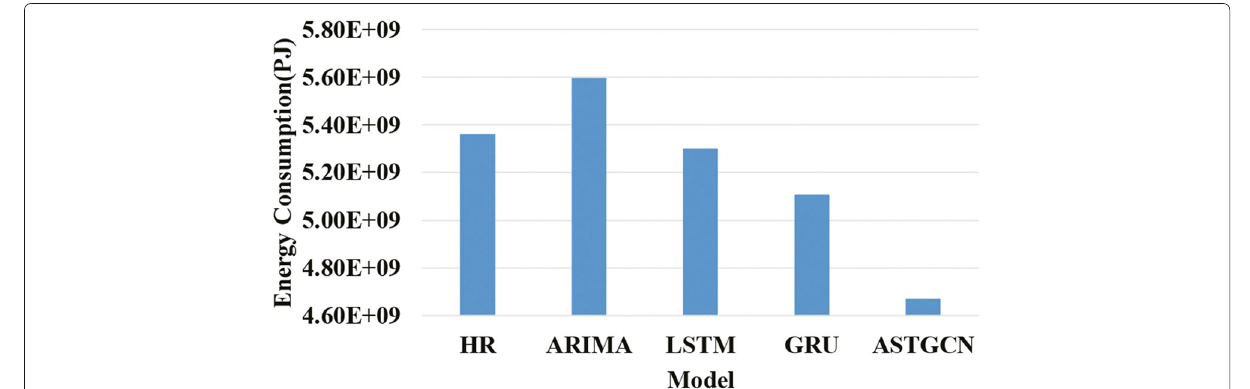
Fig. 3 Impact of different data prediction models in the cloud on energy consumption